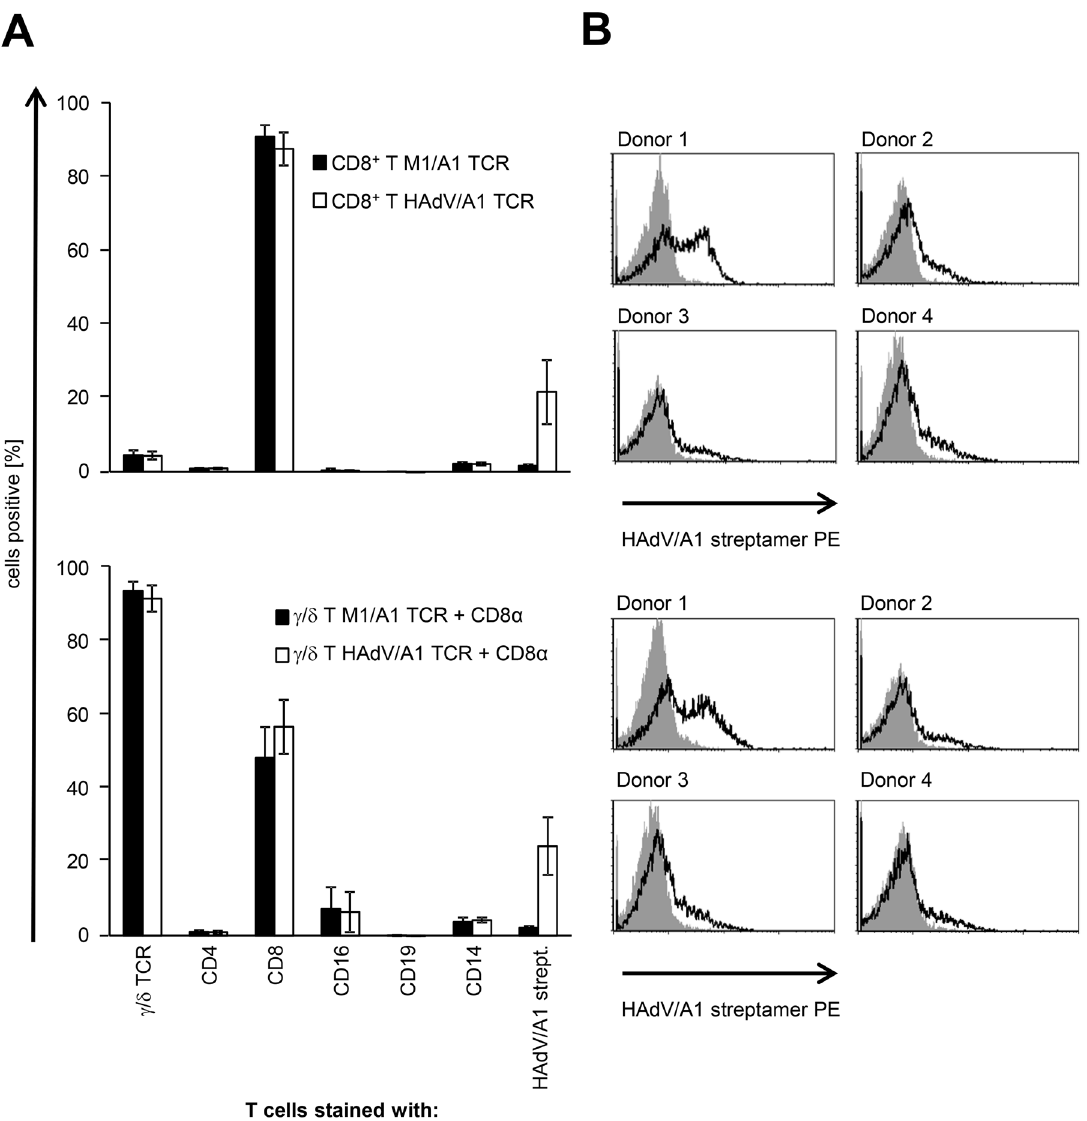
Figure 4. Surface marker and TCR expression on HAdV/A1-TCR-transfected CD8 + and c / d T cells. CD8 + T cells (A and B; upper panels) and c / d T cells (A and B; lower panels) were either electroporated with M1/A1-TCR RNA ( + CD8 a RNA in case of c / d T cells) or with HAdV/A1-TCR-RNA ( + CD8 a RNA in case of c / d T cells) and were cryoconserved 4 h after electroporation. Surface marker and TCR expression on thawed T cells was determined by staining with anti-CD4, anti-CD8, anti-CD16, anti-CD19, anti-CD14, and anti-pan c / d TCR antibodies, and the expression of the HAdV/ A1-specific TCR was determined by staining with HAdV/A1 streptamer. Expression levels were analyzed by flow-cytometry and shown as % positive cells; isotype control stainings were subtracted ( A ; average values of 4 experiments 6 SEM) or as histograms ( B ; grey histogram: T cells electroporated with M1/A1-TCR RNA, black line: T cells electroporated with HAdV/A1-TCR-RNA). Raw data are summarized in Table S4A and B in File S1.